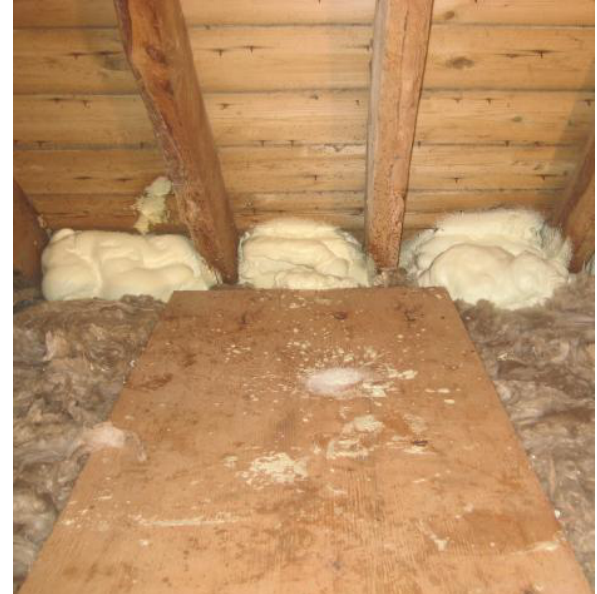
Figure 16. Monitoring the foam expansion with infra red camera 10 second Injections were then made to the missed bays, and the pipes blown clean.